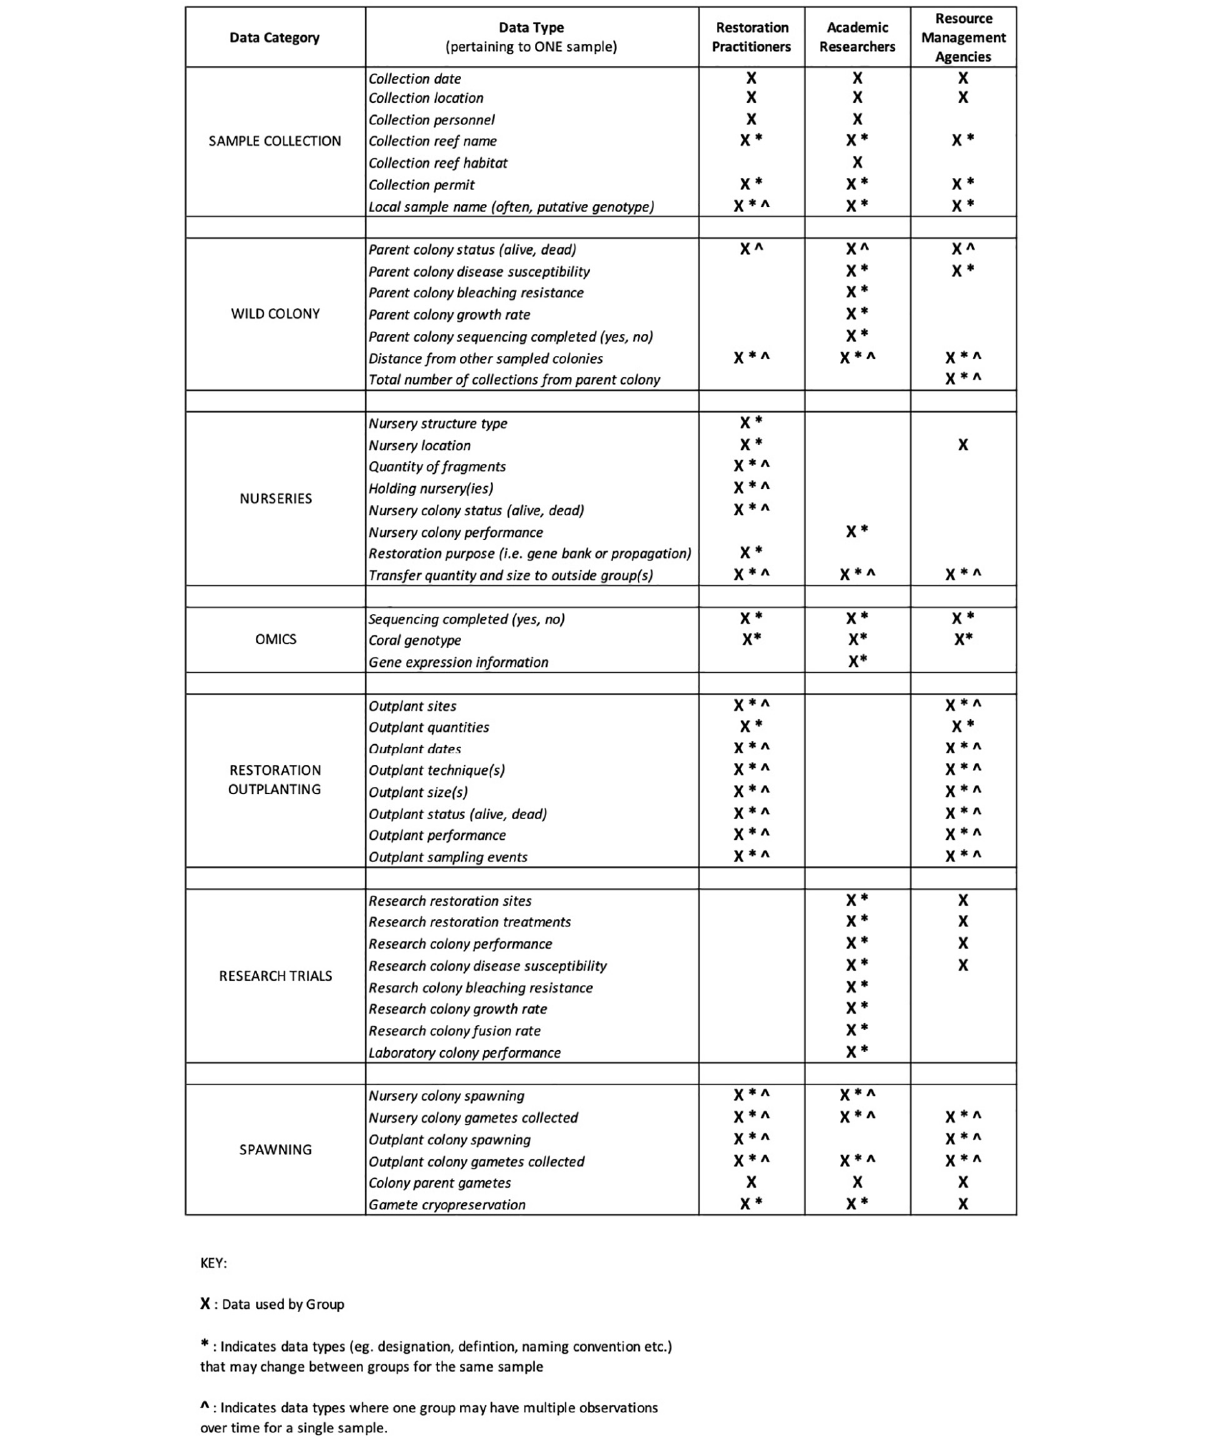
FIGURE 1 | Data types collected and used in coral restoration efforts across Restoration Practitioners, Academic Researchers, and Resource Management Agencies. Each of these broad categories may represent multiple groups working concurrently. For example, in Florida, resource management agencies could include NOAA Restoration Center, Florida Keys National Marine Sanctuary, Florida Fish and Wildlife Conservation Commission, Army Corps of Engineers, and the Department of Environmental Protection. ∗ Indicates data types that may change between groups for the same sample. ∧ Indicates data types where one group may have multiple observations over time for a single